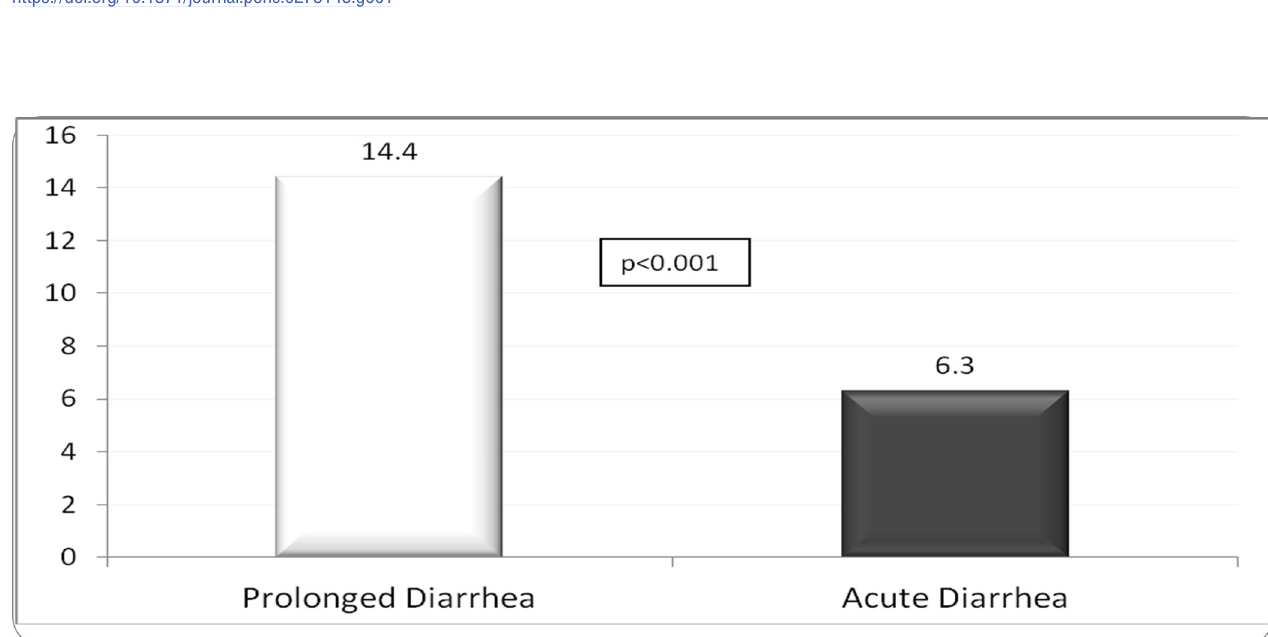
Fig 2. Percent of children required inpatient admission.